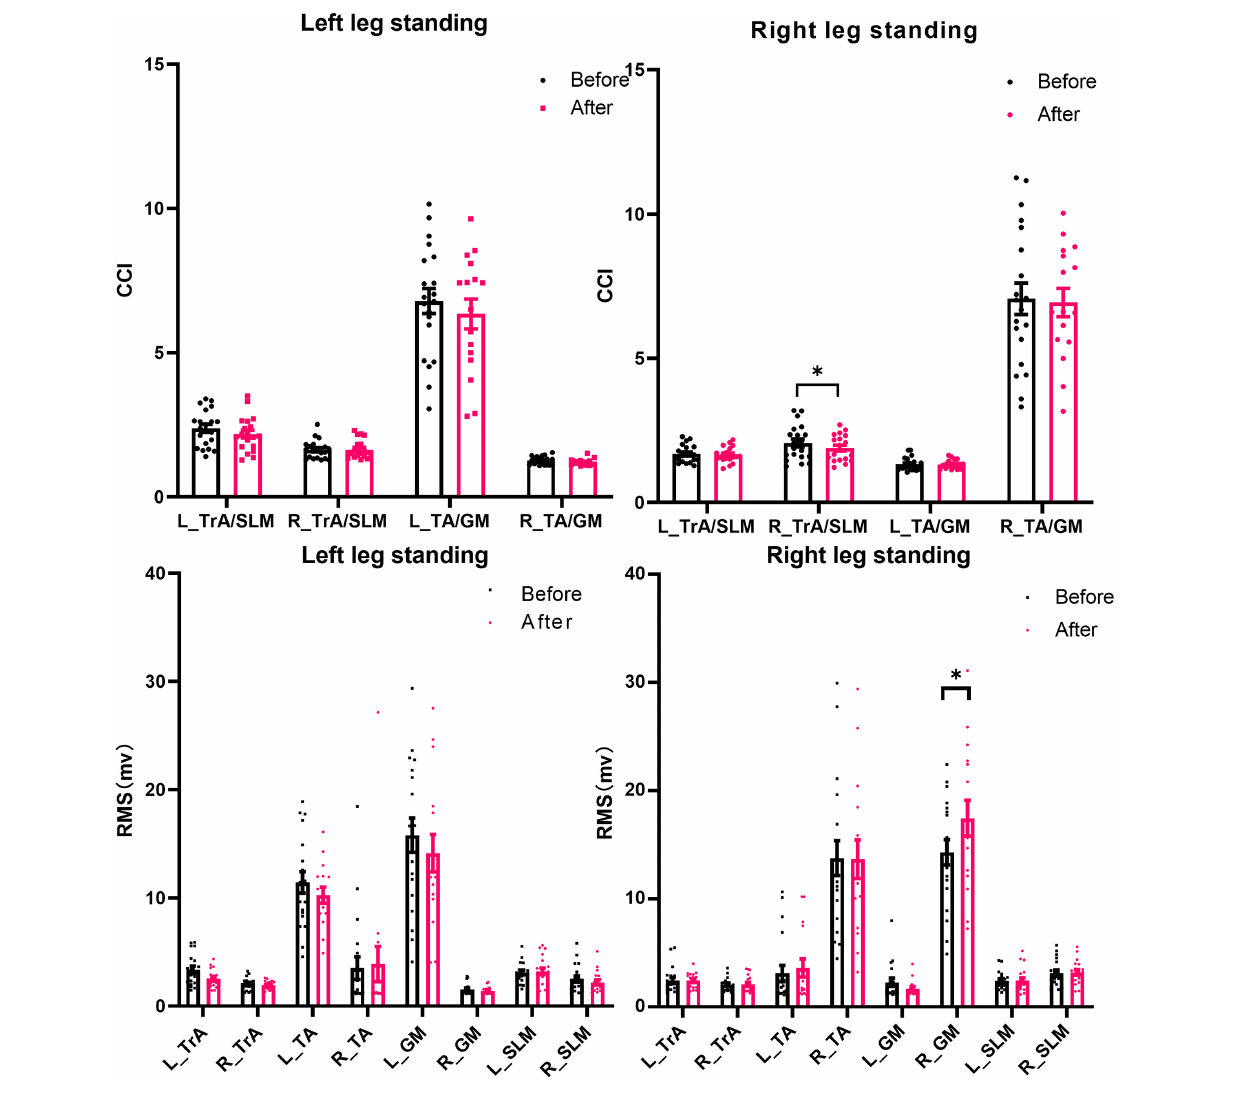
FIGURE2 The CCI and RMS of postural muscles during single-leg standing tasks before and after iTBS over the DLPFC. RMS, root mean square; CCI, co-contraction index; TrA, transversus abdominis muscle; SLM, superficial lumbar multifidus; TA, tibialis anterior muscles; GM, gastrocnemius medialis muscles; DLPFC, dorsolateral prefrontal cortex; M1, primary motor cortex. ∗ p < 0.05. Error bars indicate standard errors.